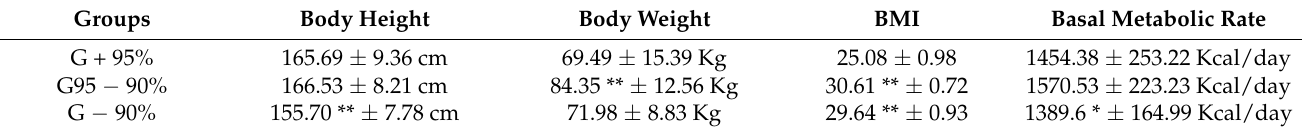
Table 2. Body Height, Body Weight, and Basal Metabolic Rate in the different MMSE percentage